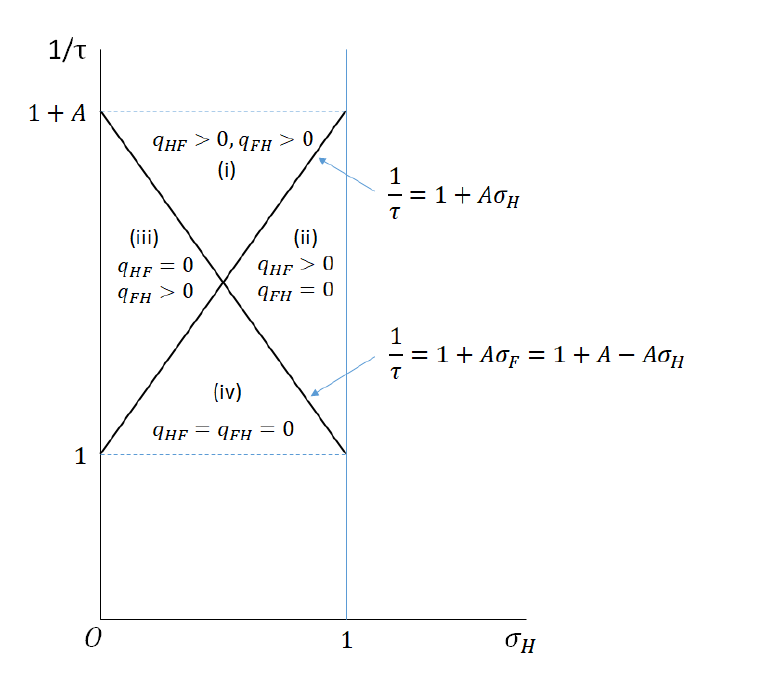
Figure 1. Possible trade